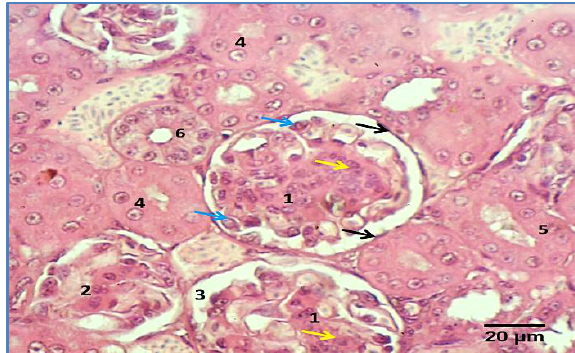
Figure, 4: section of cortex shows: mammalian nephrons (1), reptilian nephrons (2), bowman space (3), proximal convoluted tubules (4), distal convoluted tubule (5), parietal layer of Bowman capsule (Black arrows), nuclei of podocytes (Blue arrows) and nuclei of mesangial cells (Yellow arrows) H and E phloxine